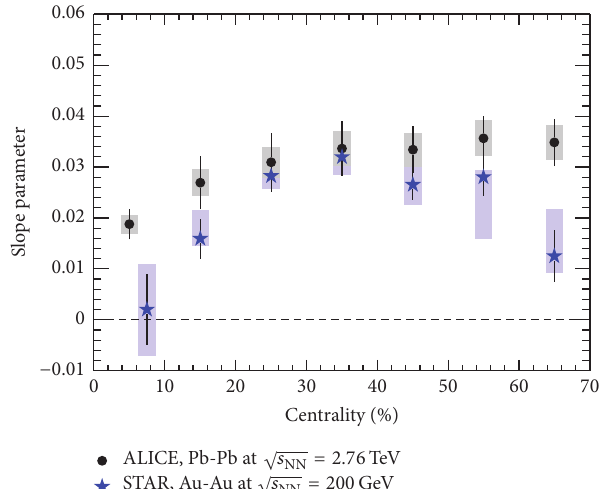
Figure 16: Slope parameter 𝑟 as a function of centrality for 200 GeV Au+Au [80] and 2.76 TeV Pb+Pb [82]. Statistical (systematic) uncertainties are indicated by vertical bars (shaded boxes).